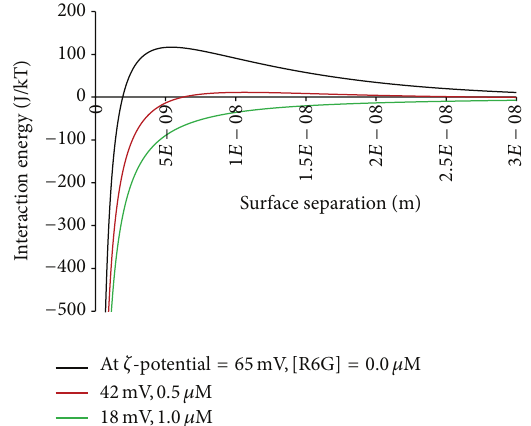
Figure 6: The theoretical potential energy relative to kT versus surface separation is plotted below for clean nanoparticles and ones preincubated in 0.5 and 1 𝜇 M R6G. These clearly show the trend towardsaggregationandclearlyindicatethataggregationisexpected for the 1 𝜇 M case.